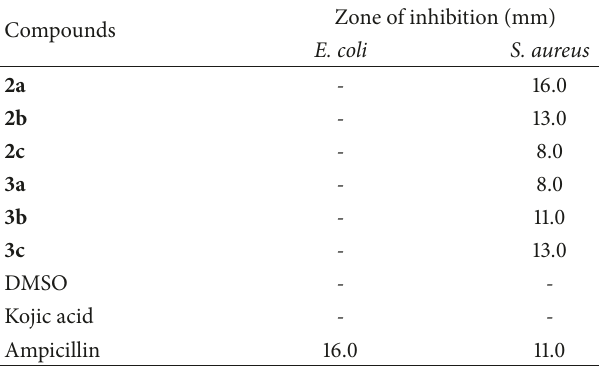
Table 2: Inhibition zones of 2a–c and 3a–c . Compounds